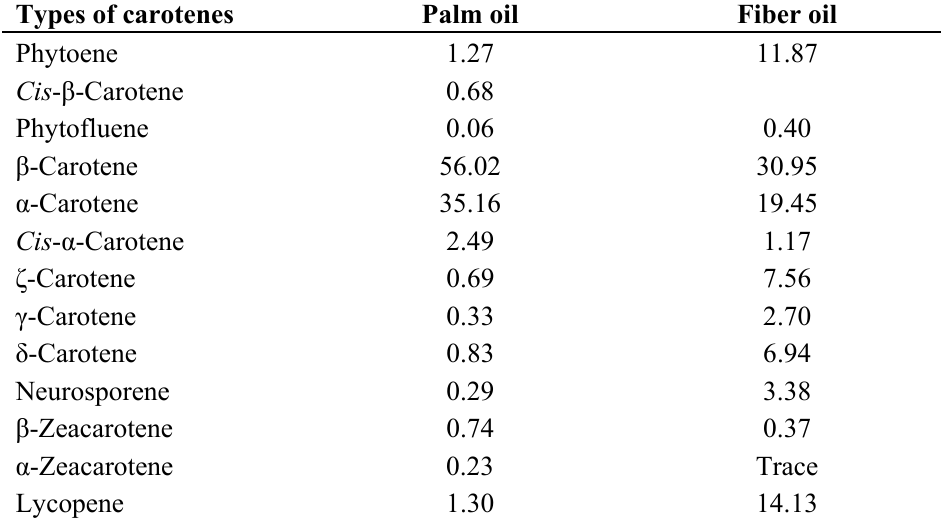
Table 2. Composition (%) of carotenes in palm oil and palm fiber oil